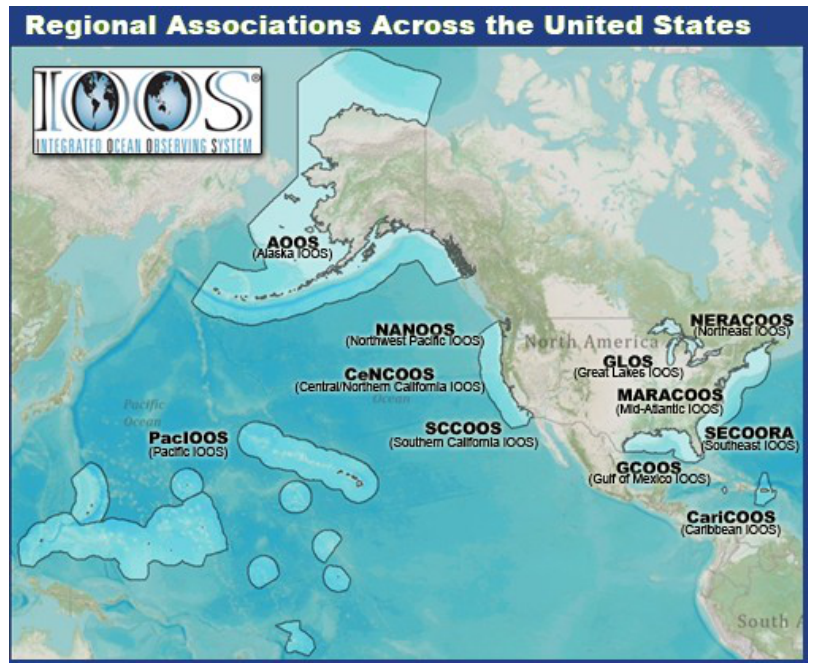
Figure 1. The 11 United States Integrated Ocean Observing System (U.S. IOOS) Regional Associations, reproduced with permission from © 2011 Dynamic Network Services—DynDNS.com Internet